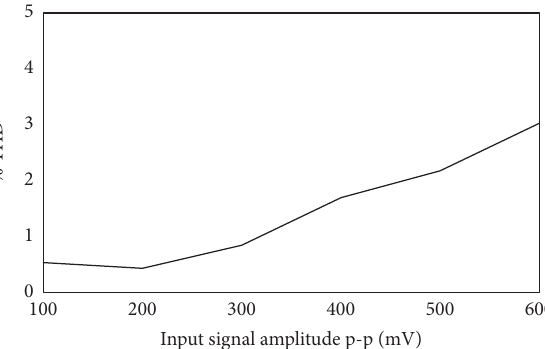
Figure 12: % THD variation with p-p input signal